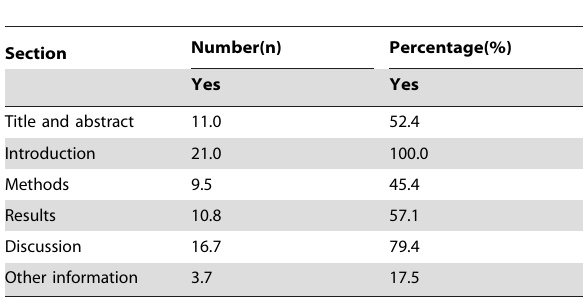
Figure 1. Flow diagram for the selection of articles for inclusion in systematic review.